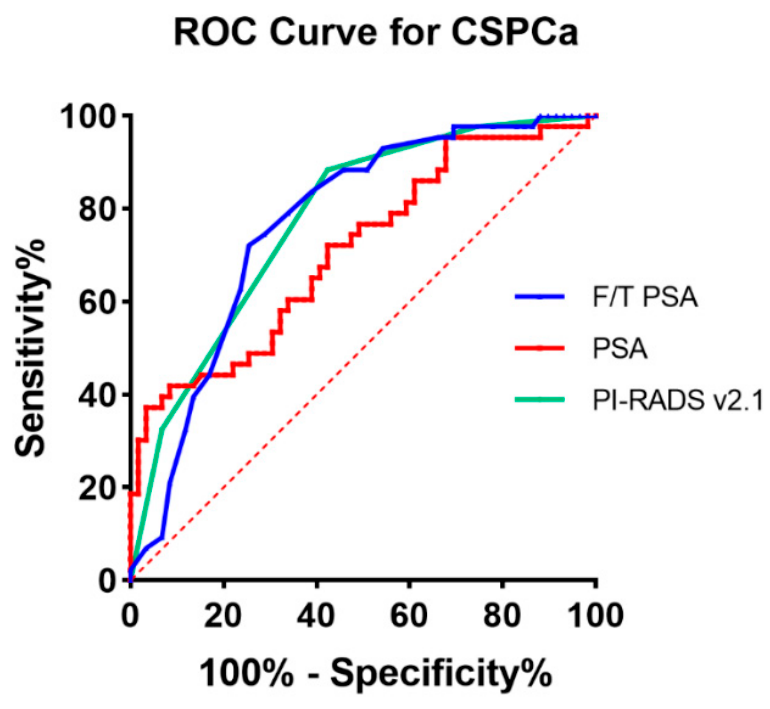
Figure 1. ROC curves of PSA, F/T PSA, and PI-RADS v2.1 in predicting CSPCa. In univariate logistic regression analysis, age, PSA, F/T PSA (<0.135 vs. ≥ 0.135), and PI-RADS v2.1( ≥ 3 vs. <3) showed significant associations with the biopsy results. However, in multivariate logistic regression analysis, only age, F/T PSA, and PI-RADS v2.1 remained independent predictors for CSPCa (Table S1).